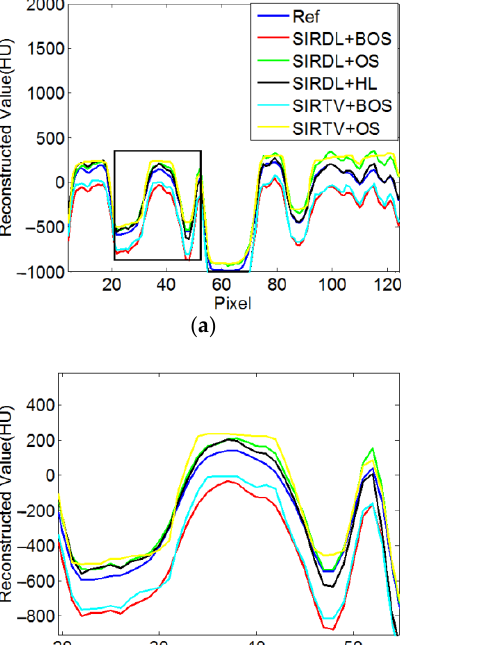
Figure 6. Reconstructed ROIs from normal-dose real sheep data using five different methods: ( a ) SIRTV + BOS; ( b ) SIRTV + OS; ( c ) SIRDL + BOS; ( d ) SIRDL + OS; ( e ) SIRDL + HL. The display window is [ − 700 800]HU.